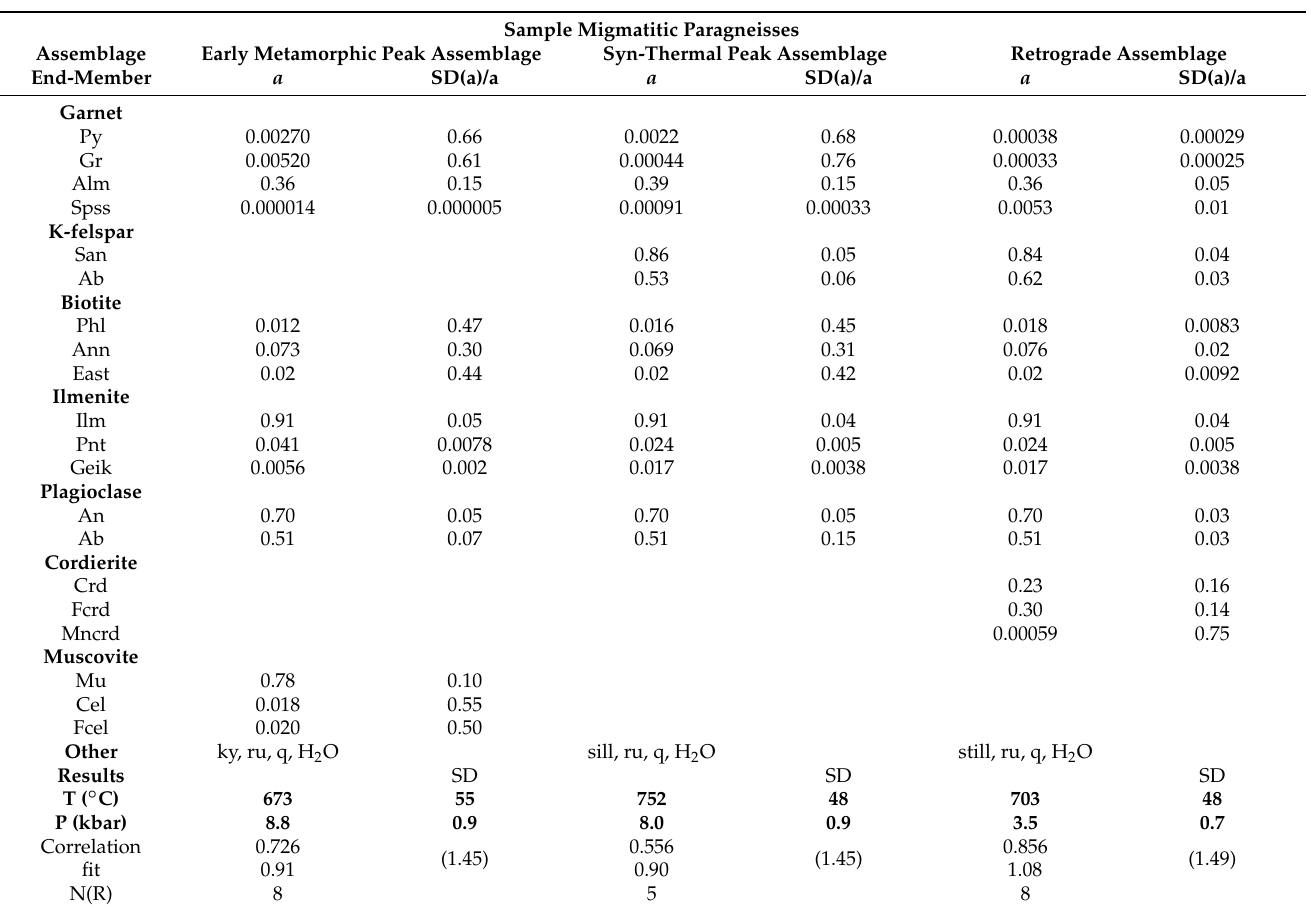
Table 3. Summary of the results of the average P-T calculations (values in bold) of an early metamor- phic peak, syn-thermal peak, and retrograde mineral assemblages of the migmatitic paragneisses of the Filali unit a